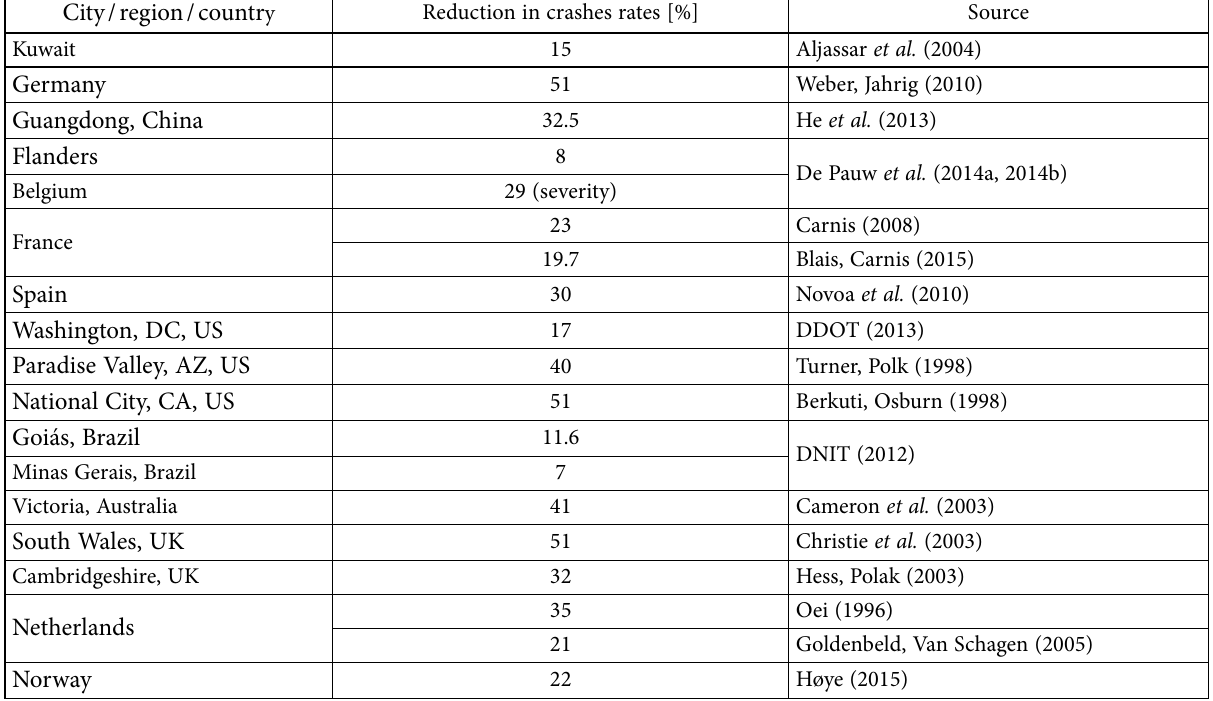
Table 1. Cases of accident rates reduction with the use of cameras for speed control City / region / countr